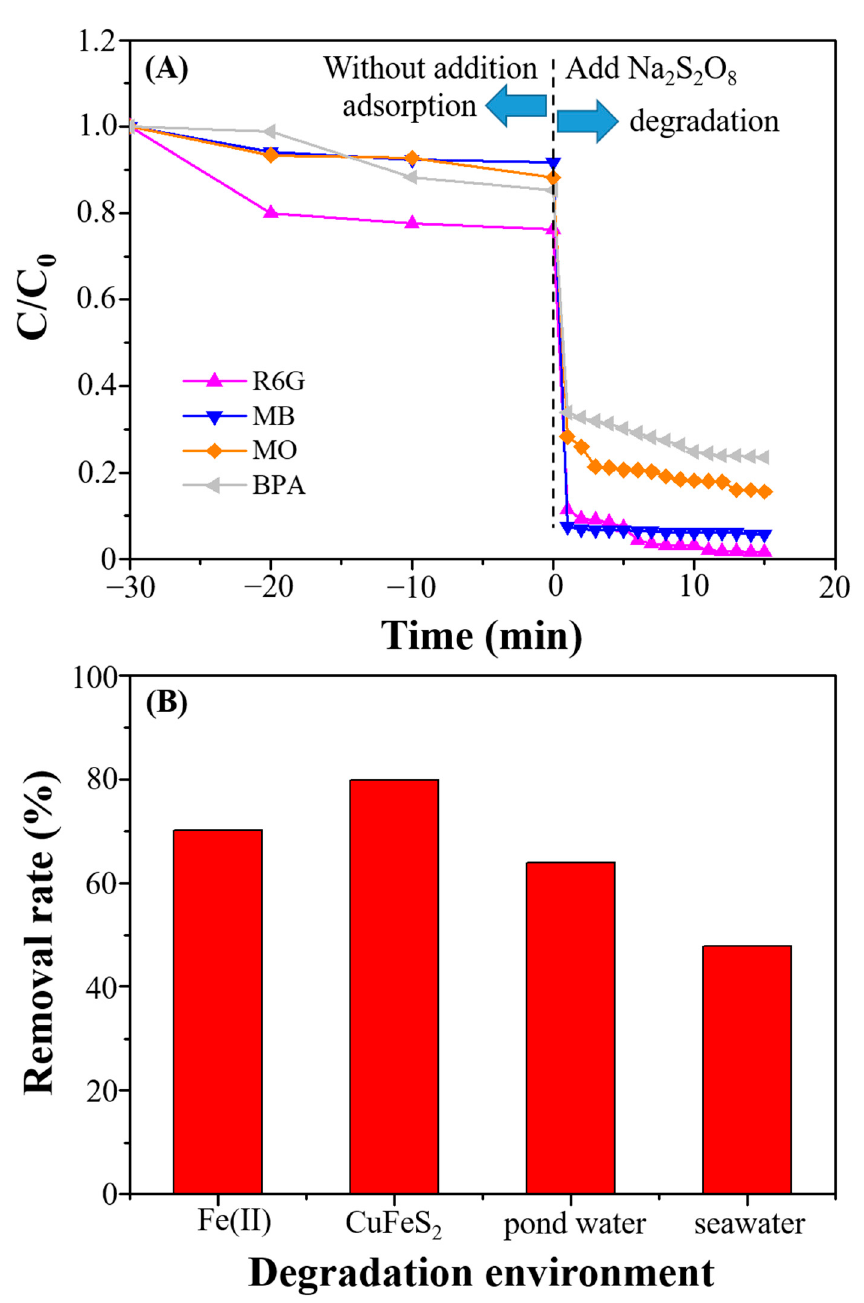
Figure 15. Fenton-like reaction of ( A ) different dyestuff by the H-CuFeS 2 samples, ( B ) TOC analysis of different degradation systems by using Fe(II) and the H-CuFeS 2 samples in the different environmental water samples.